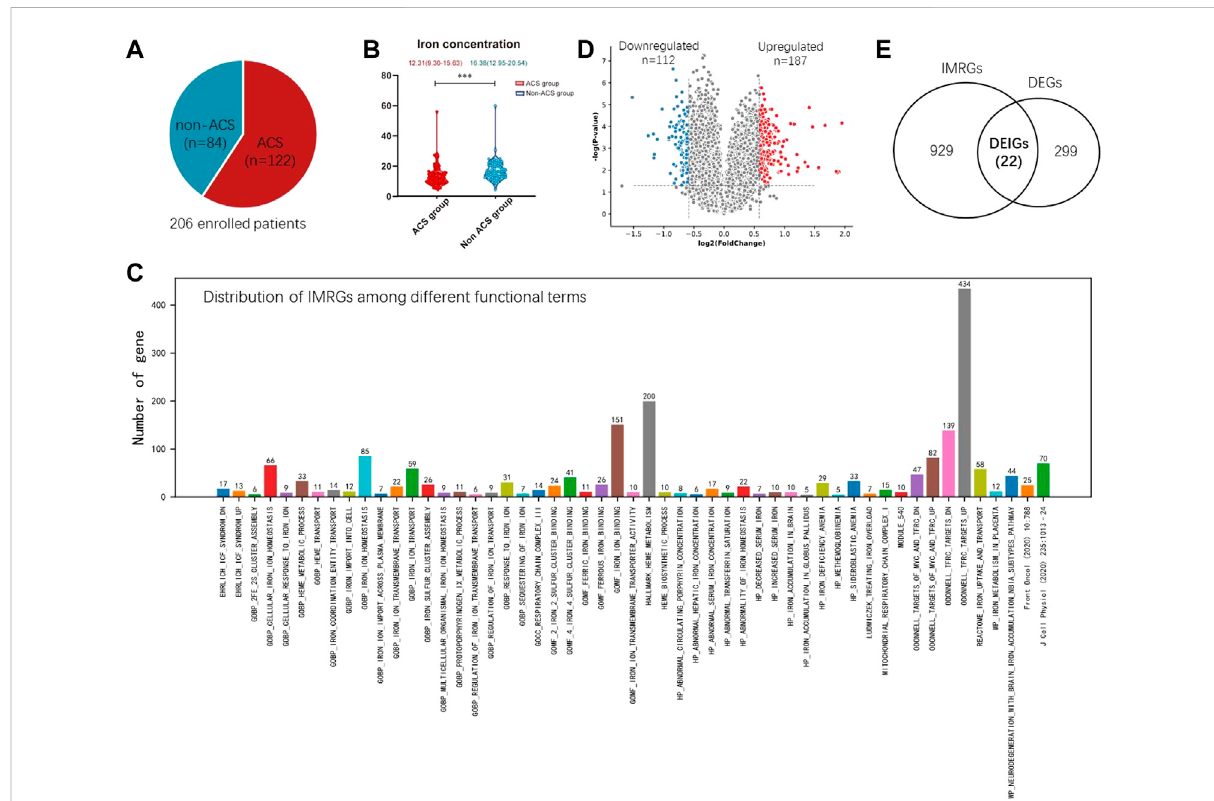
FIGURE 1 EstablishmentofIMRGs. (A) Compositionofenrolled samples. (B) Boxplotshowingtheiron difference clinically. (C) Identi fi cationofDEGs from the training set GSE61144. (D) Venn diagram of all DEGs and IMRGs. (E) Distribution of iron metabolism-related genes among different functional